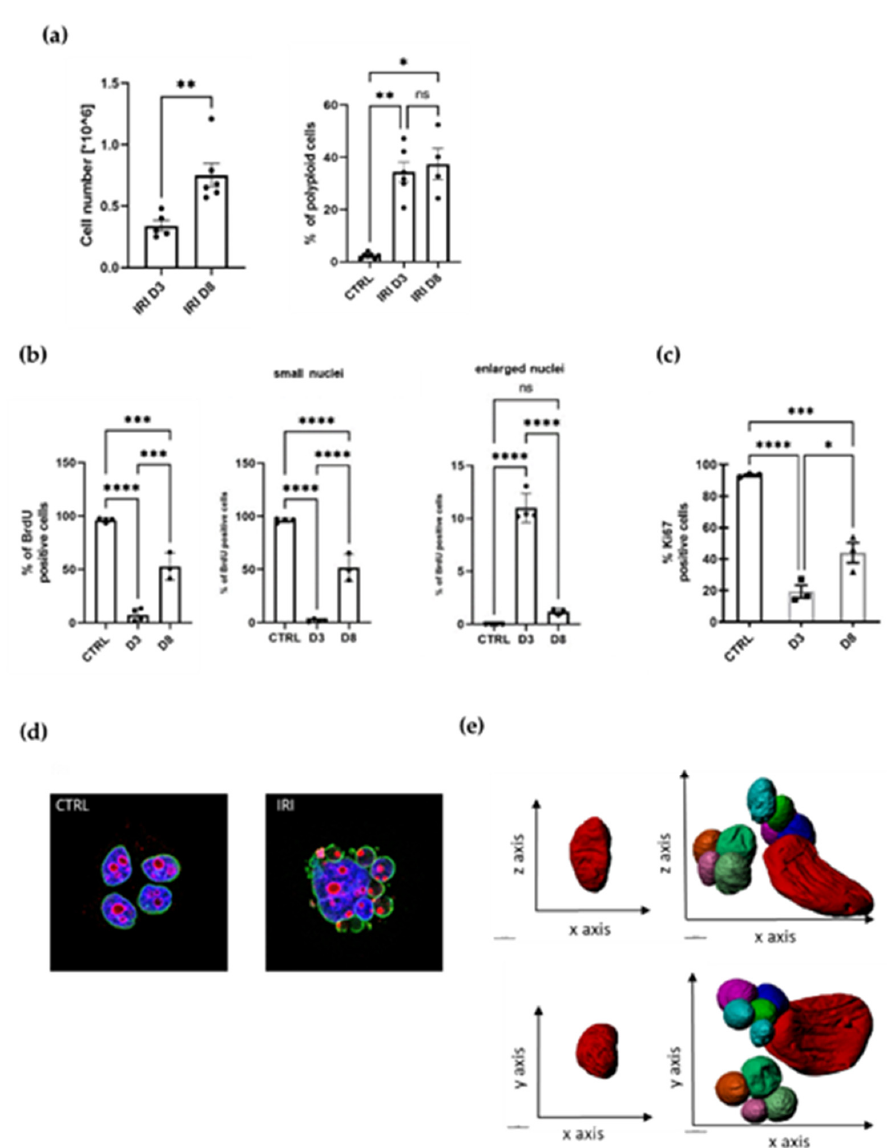
Figure 1. Therapy-induced senescence is associated with increased polyploidization and followed by resumption of proliferation. ( a ) MCF-7 breast cancer cells counted at day three (D3) and day eight (D8) after 24 h treatment with IRI (left panel); quantification of polyploid cells assessed with flow cytometry at day three (D3) and day eight (D8), >4c DNA cells were considered as polyploid (right panel); mean of at least three independent experiments ± SEM; statistical significance: * 0.01 < p < 0.05, ** 0.001 < p < 0.01. ( b ) Quantification of BrdU-positive MCF-7 cells; mean of at least three independent experiments ± SEM; statistical significance: * 0.01 < p < 0.05, ** 0.001 < p <0.01, *** p < 0.001, **** p < 0.0001 ( c ) Quantification of Ki67-stained MCF-7 cells at day three (D3) and day eight (D8 ; mean of at least three independent experiments ± SEM; statistical significance: * 0.01 < p < 0.05, *** p < 0.001, **** p < 0.0001. ( d ) Representative images of control and treated cells stained with lamin a/c (green) and Ki67 (red), nuclei stained with Hoechst 33342 (blue). ( e ) 3D reconstruction of the serial block-face scanning electron microscopy (SBEM) sections. Representative reconstruction of control (on the left) and IRI-treated MCF-7 cells at D8 (on the right); scale bar = 50 µM. This is a fairly common phenomenon, similar to that seen in cells of other cancer cell lines, in which proliferation is temporarily arrested after various treatments (Figure S1b).